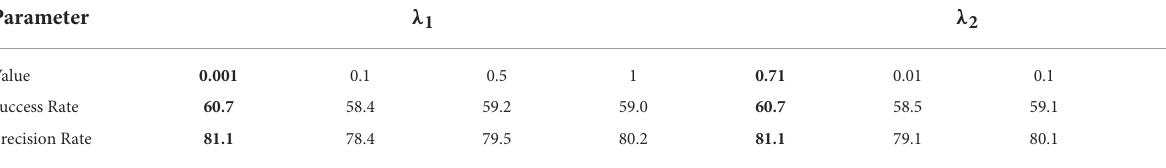
TABLE 1 The success rate and precision rate (percentage) related to the varying number of regularization constraint coefficients on VisDrone2018-test-dev. Parameter λ 1 λ